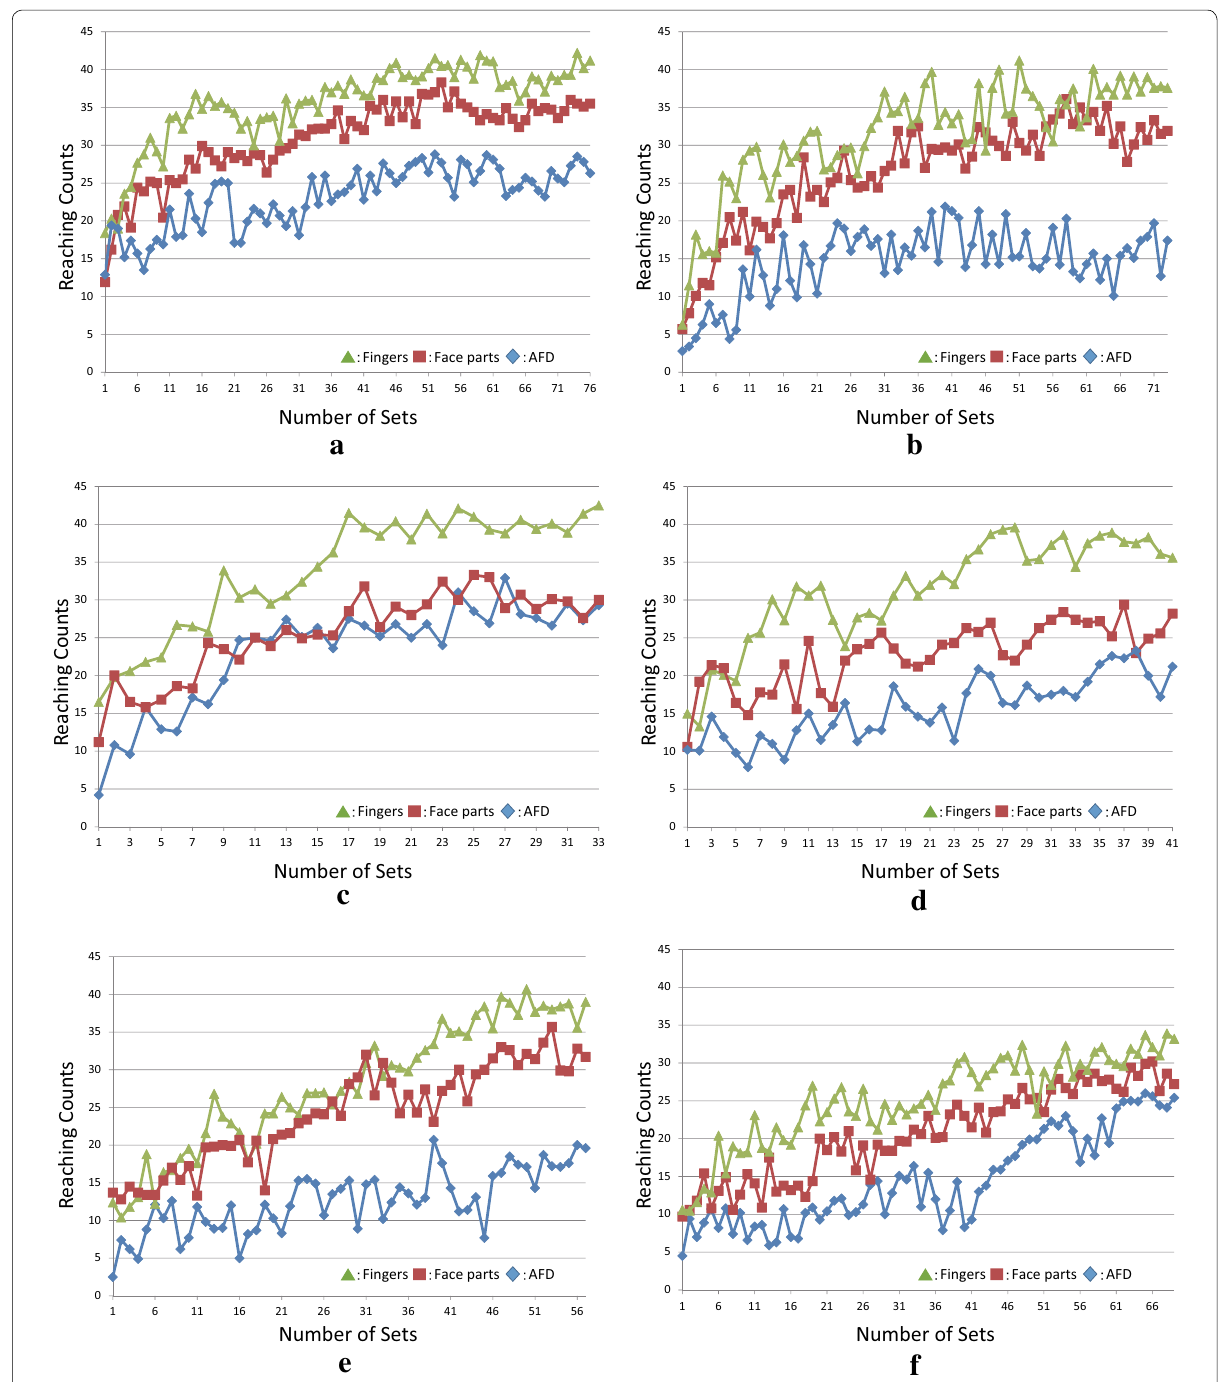
Fig. 8 Learning curves of successful reaching counts for the six subjects a , b , c , d , e and f respectively. For all the given curves, the green line shows reaching counts when reaching targets are fingertips, the red line shows reaching counts when reaching targets are positions on the subjects’ faces, and the blue line shows reaching counts when reaching targets are buttons on the